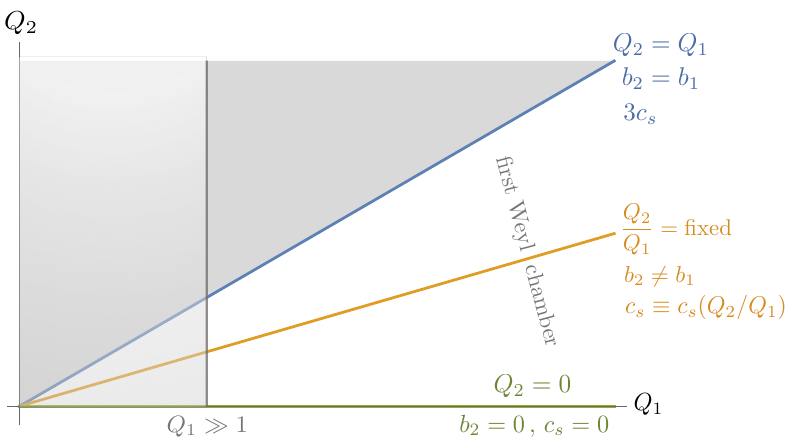
Figure 2 . The relation (3.19) is plotted in the (cid:12)rst Weyl chamber where Q 1 (cid:21) Q 2 (cid:21) 0. To each (cid:12)xed ratio Q 2 =Q 1 with Q 1 1 there generically corresponds an orange line along which the (cid:29) expansion (3.22) has the same ignorance coe(cid:14)cients and the same non-universal contribution c s at order one (see also table 3). The blue and green lines describe limiting con(cid:12)gurations of enhanced symmetry, analyzed in section 3.2 and at the end of